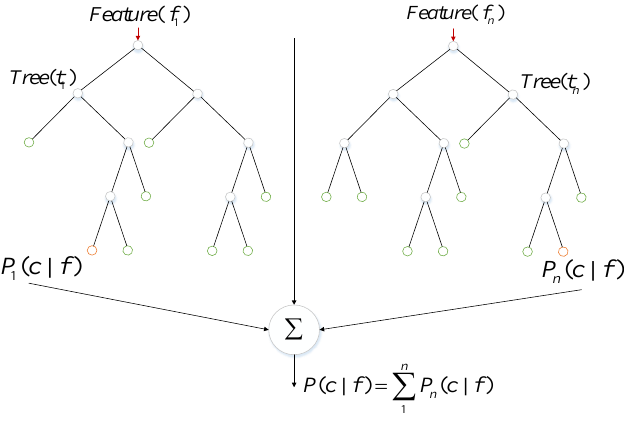
Figure 4. Extreme random tree algorithm.